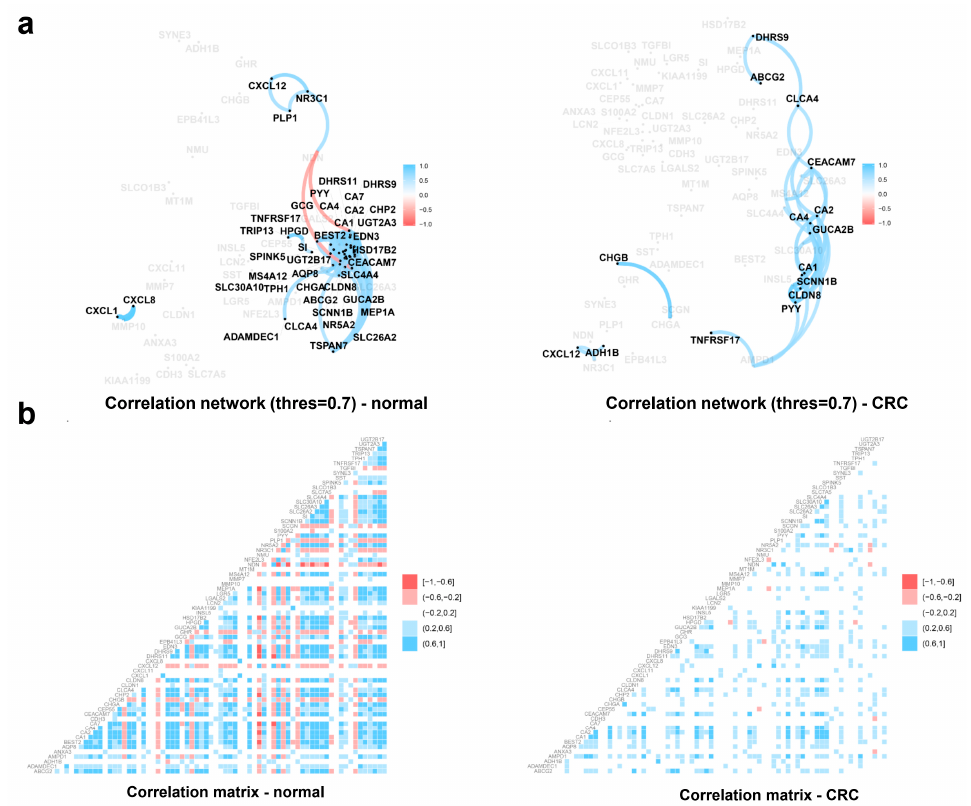
Figure 3. Correlation analysis of biomarker candidates of cancer samples and non-cancerous samples. ( a ) Correlation network of biomarkers in cancer samples and non-cancerous samples. Blurred edges in the network were the ones with correlation strength (in absolute value) below the cut-off value 0.7. The blue color indicates positive correlations while red color indicates negative correlations ( b ) Correlation matrix of biomarkers in cancer samples and non-cancerous samples.